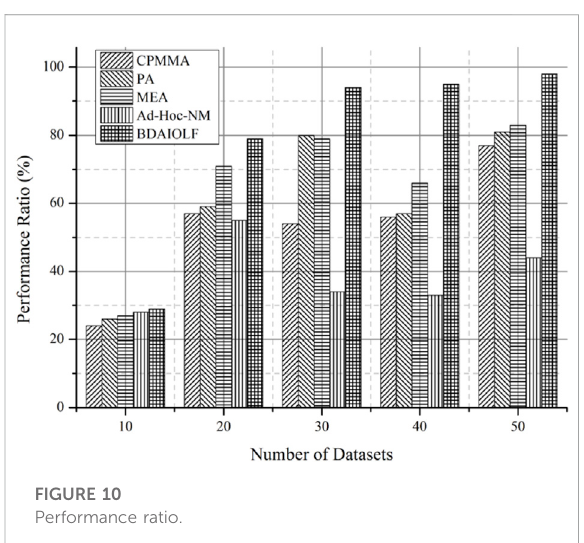
FIGURE 10 Performance